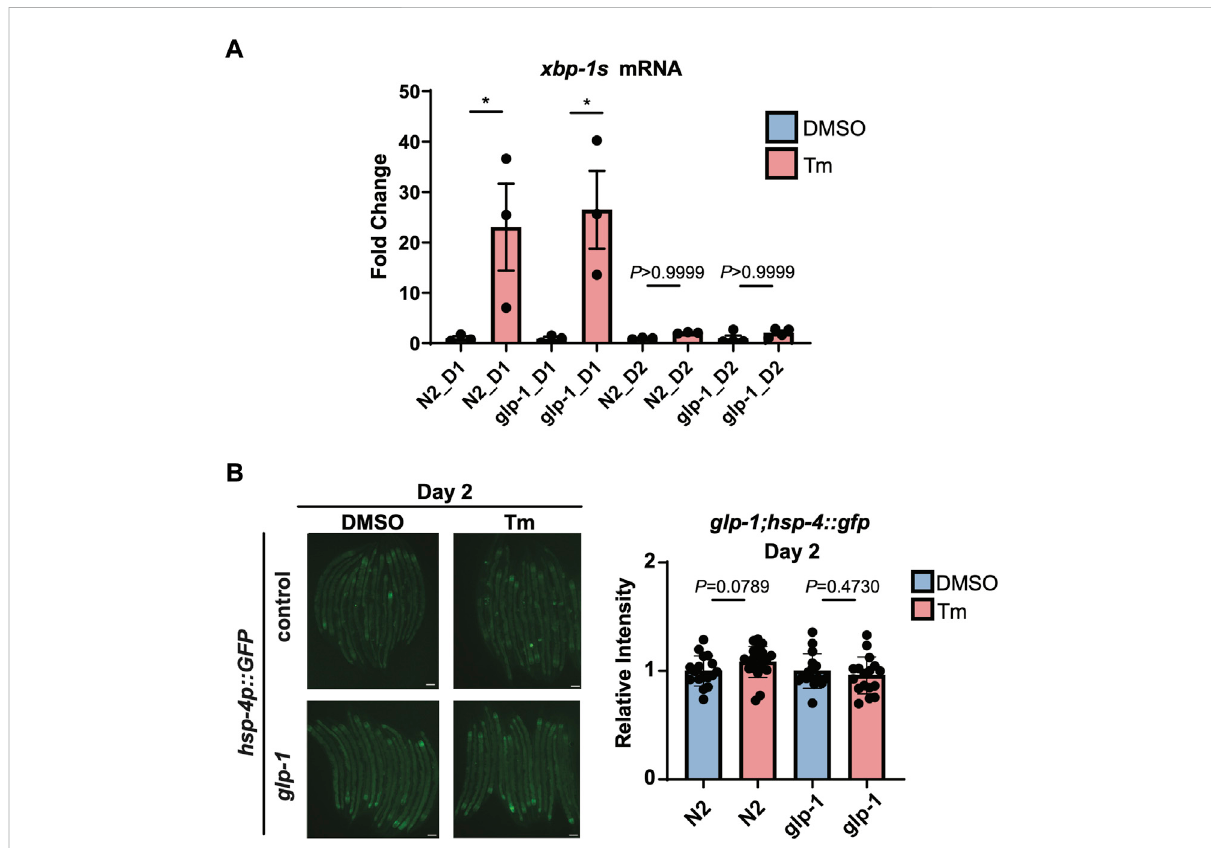
FIGURE 4 glp-1 mutation does not prevent age-related decline in UPR ER activation. (A) qRT-PCR measurement of hsp-4 and xbp-1s mRNA after 6 h of tunicamycin (Tm) or DMSO treatment in N2 or glp-1 ( e2141 ) animals at the beginning of Day 1 (D1) or Day 2 (D2) of adulthood. * p < 0.05, ns = not signi fi cant,One-WayANOVAwithTukey ’ smultiplecomparisontest. (B) Epi fl uorescencemicroscopyandquanti fi cationofthe fl uorescenceofN2or glp-1 animals at Day 2 (D2) of adulthood after 6 h of treatment with Tunicamycin (Tm) or DMSO. Scalebars, 200 µm. Signi fi cance assessed by Unpaired t -test (DMSO vs.